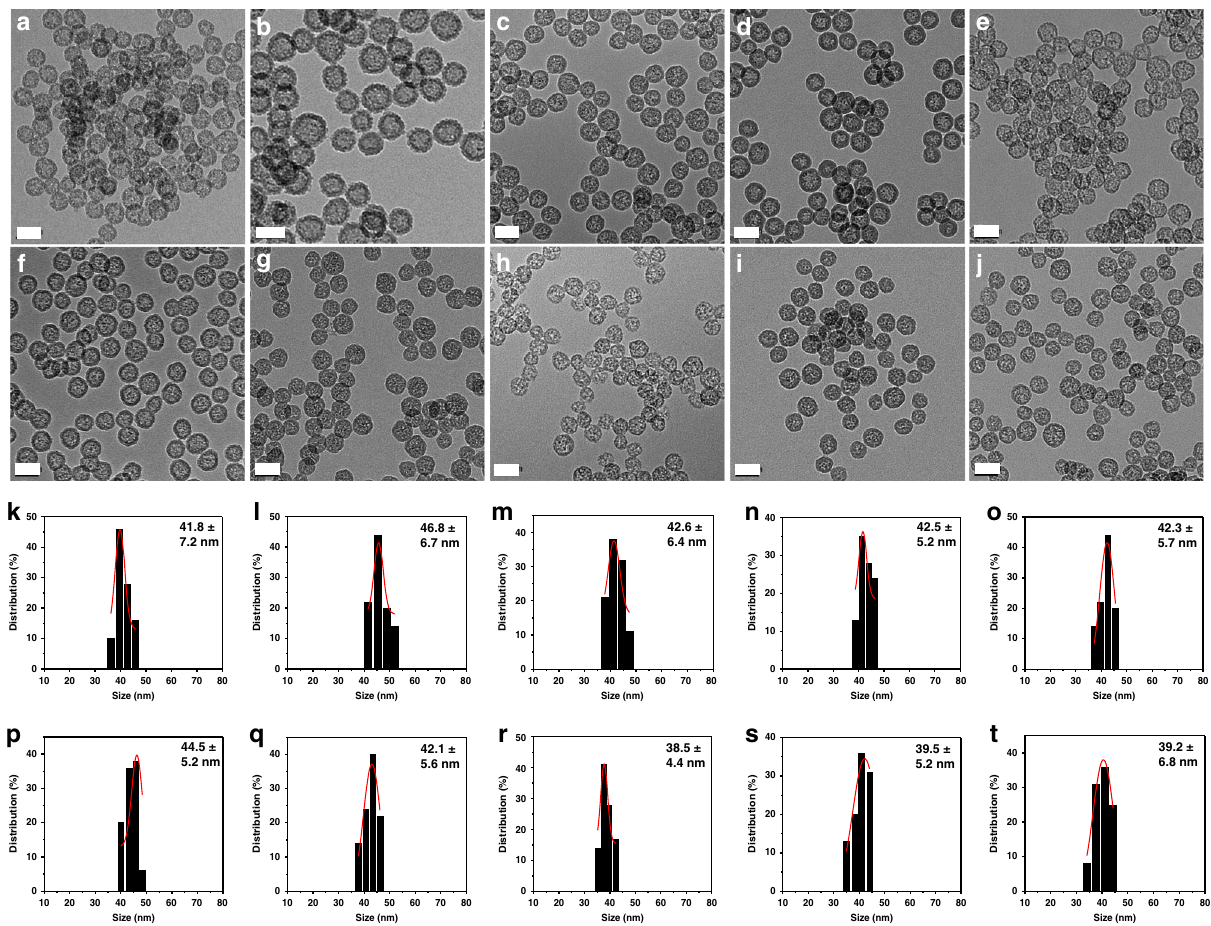
Fig. 2 Morphology and size distributions of multiple small-sized HMONs. TEM images ( a – j ) and size distributions ( k – t ) of sub-50 nm HMONs with multiple framework hybridization of diverse organic moieties. Mono hybridization: thioether ( a , k ), phenylene ( b , l ), ethane ( c , m ), ethylene ( d , n ). Double hybridization: thioether/phenylene ( e , o ), phenylene/ethane ( f , p ), ethane/ethylene ( g , q ). Triple hybridization: thioether/phenylene/ethane ( h , r ), thioether/phenylene/ethylene ( i , s ). Quadruple hybridization: thioether/phenylene/ethane/ethylene ( j , t ). Scale bar: 50 nm. Despite different framework hybridization, the as-synthesized HMONs demonstrate a uniform hollow-structured spherical morphology with size below 50 nm, which con fi rms the advantage of this well-established ammonia-assisted hot water etching strategy in the generic synthesis of a library of small-sized